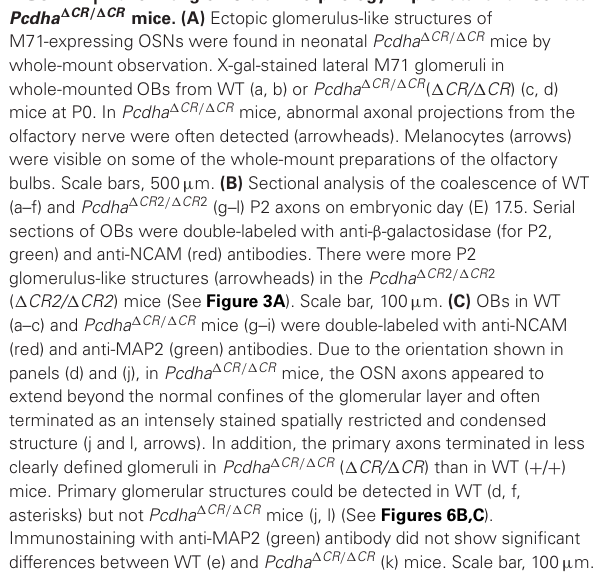
Sectional analysis of the OBs on E17.5 clearly